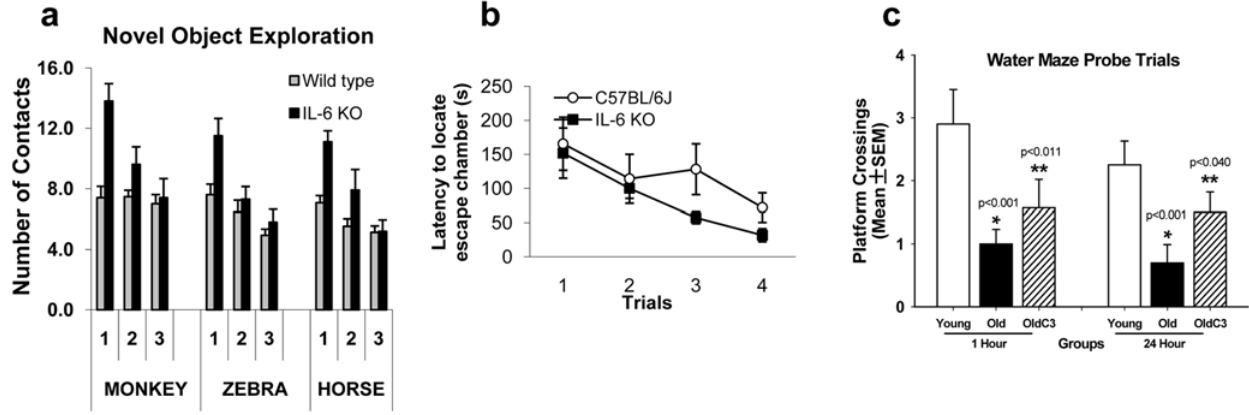
Figure 6. Old IL-6-/- mice or old mice treated with the SOD mimetic, C 3 , exhibit preserved spatial working memory. (a) Old IL-6-/- mice show improved learning performance on the Novel Object task. Old (22 month) C57BL6 and IL-6-/- mice (on a C57B6 background) were tested for habituation to each of three novel objects, and IL-6-/- mice showed significantly better performance than wild-type mice (statistics shown in Results). (b) Barne’s maze escape latency (time to find the darkened chamber) showed a statistically significant decrease in latency in old IL-6-/- mice but wild- type mice (statistics included in results section). (c) Preservation of spatial learning and memory on the Morris water maze by chronic treatment with C 3 . Young (6 M), old (24 M), and old- C 3 -treated (24 M) male mice were tested on components of the Morris water maze as previously described[27]. Graph shows performance on the probe trial component for the specific set of male mice used in the current study. Data from the probe component of the trial are shown for the immediate (1 h) recall, and delayed (24 h) recall. C 3 significantly preserved performance at both time-points. Data are mean 6 SEM, and were analyzed by 2-Way ANOVA followed by Tukey’s post-hoc test, n=13 young, n=10 old, n=12 old- C 3